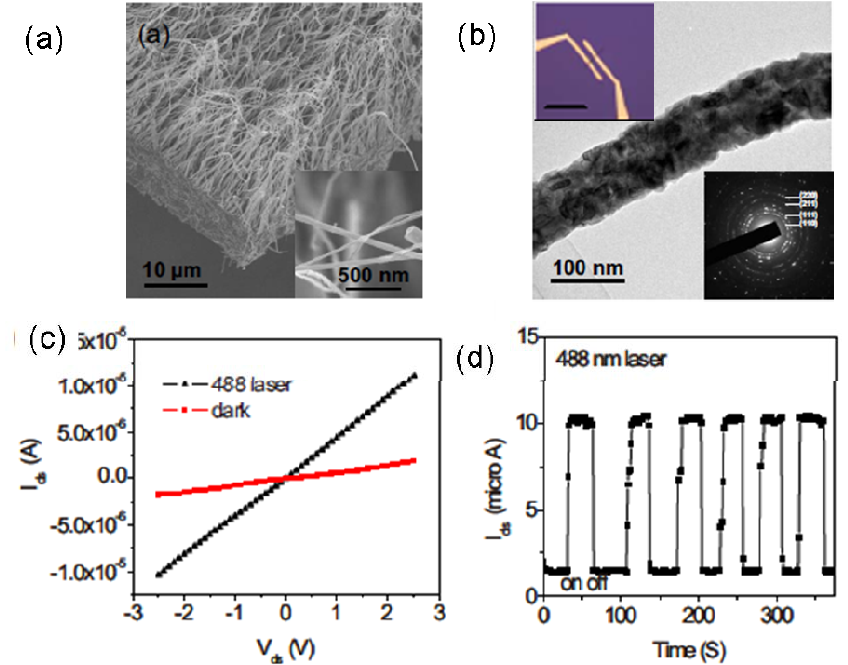
Figure 5. (a, b) Scanning electron microscopy (SEM) image, transmission electron microscopy (TEM) image and selected-area electron diffraction (SAED) pattern of O NWs; (c) I-V curves show dark current and photocurrent of a single Cu Cu 2 488 nm laser illumination; (d) I-t curves recorded with the 488 nm laser illumination turned on and off repeatedly. Reproduced from